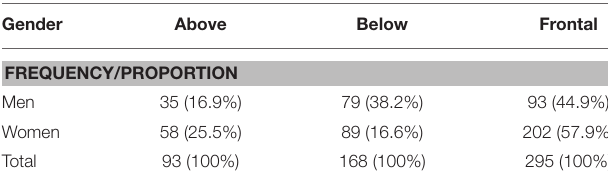
TABLE 1 | Frequency and percentage of